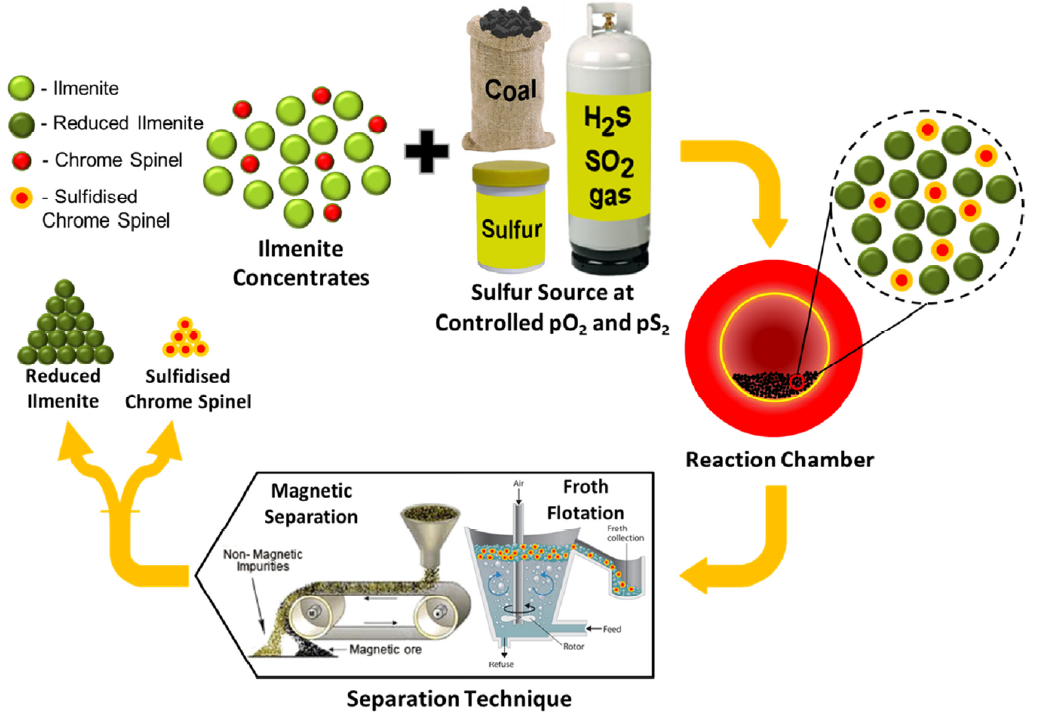
Figure 1. Schematic diagram showing the proposed process for chrome spinel impurity removal from contaminated ilmenite concentrates through selective sulphidation. The process is in two parts: Part 1 shows the selective sulphidation of the chrome spinel grains; Part 2: involves the physical separation of the sulphidised chrome spinels from the reduced ilmenite.